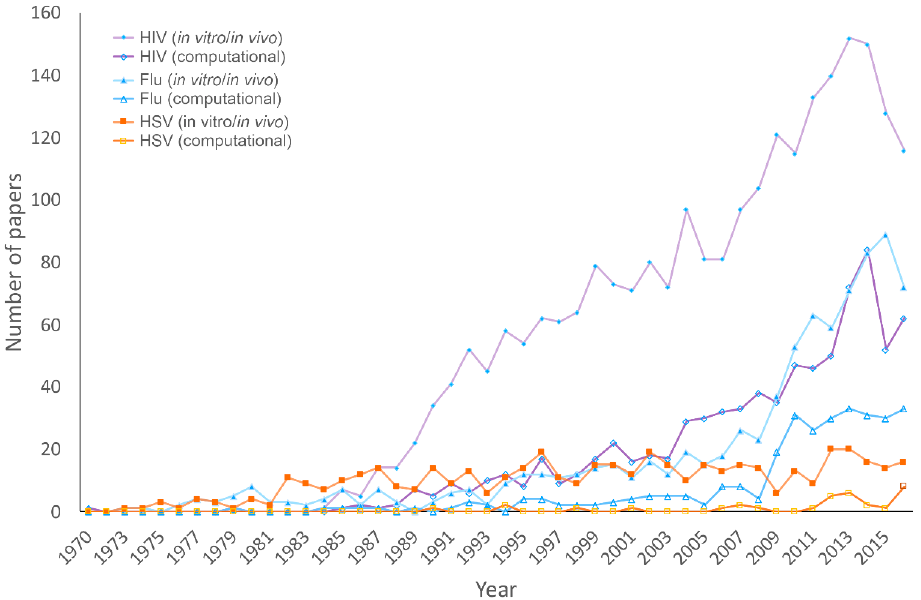
Figure 1. Number of papers concerning viruses published each year since 1970. Papers related to HIV, influenza, and HHV were identified in PubMed using keywords shown in the figure legend (in vitro or in vivo, and computational).